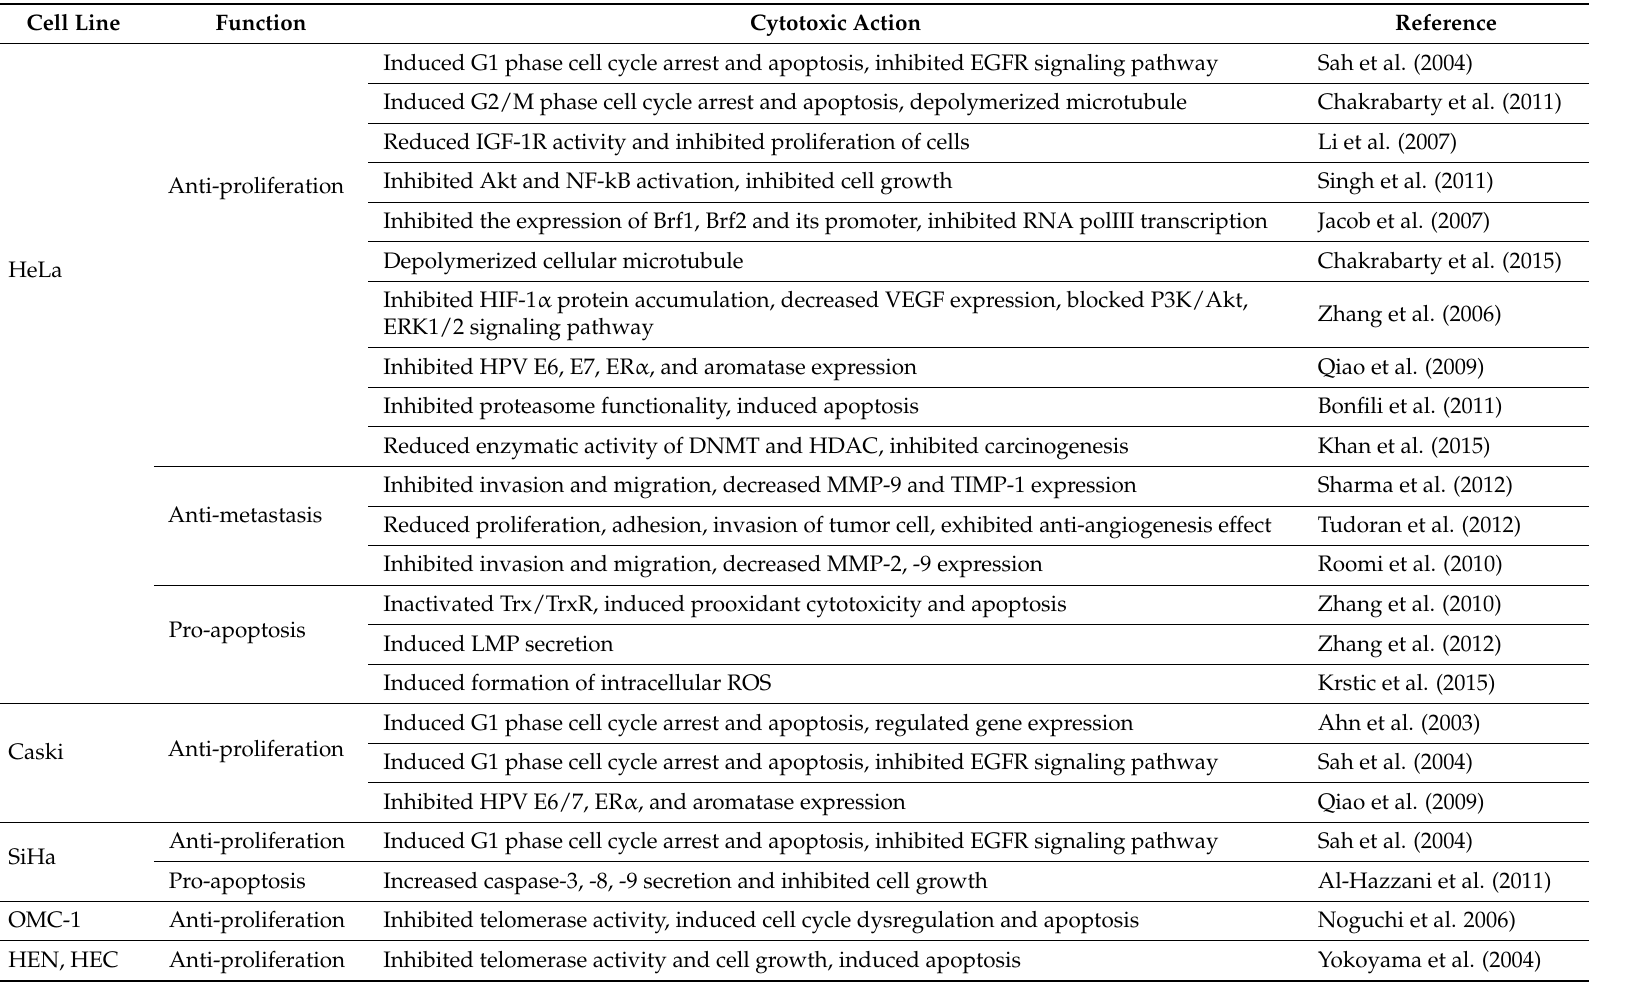
Table 2. Cytotoxic activities of EGCG on human cervical cancer cell